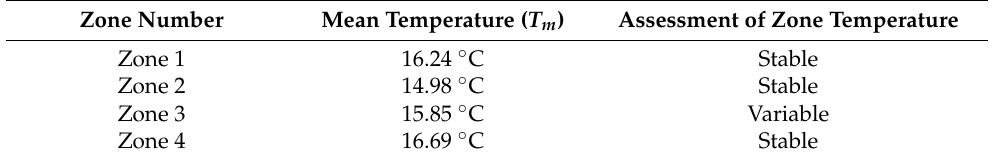
Table 3. Mean temperatures of each zone.